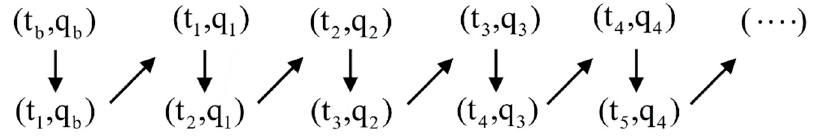
Figure 4. The process of the multiple cycling utilization of the physical retrieval method.